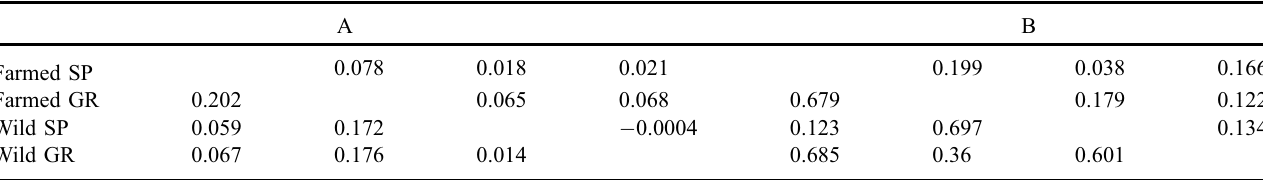
Table 3. Pairwise F ST (below diagonal) and Nei distance (above diagonal) values among samples of S. aurata (A) and D. labrax